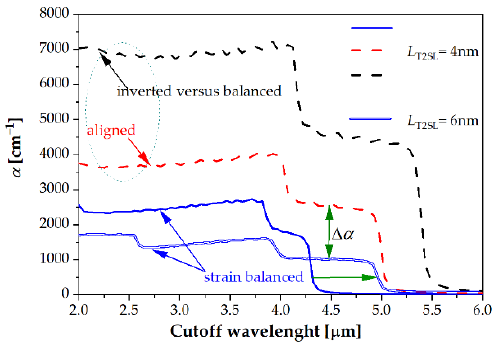
Figure 4. Theoretical simulation of the absorption coefficients for the strain balanced and strained SL at T = 150 K for the layer thickness L T2SL = 4 nm ( x = 0.30) and L T2SL = 6 nm ( x = 0.30).